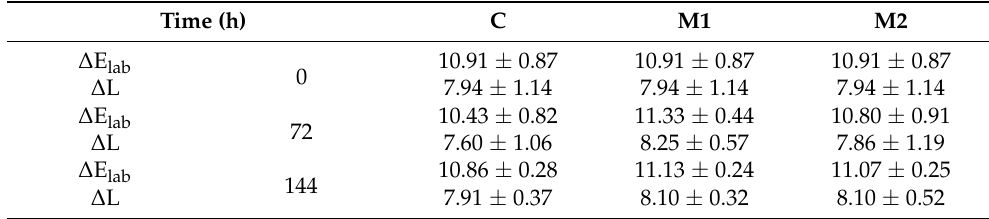
Table 2. The ∆ E lab of sliced chicken